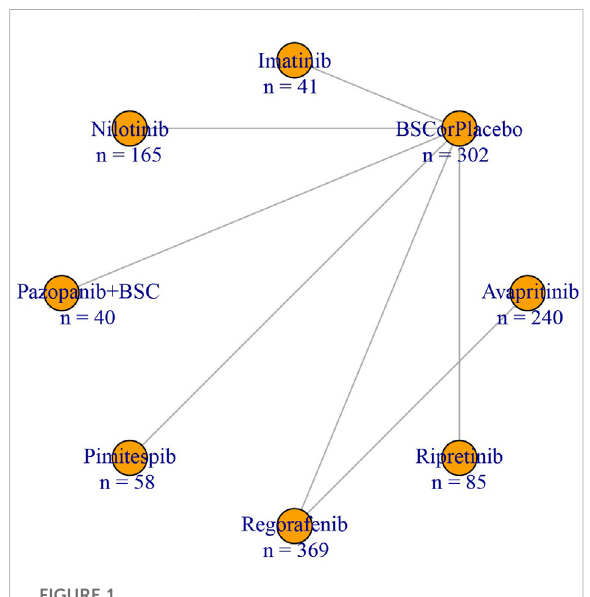
FIGURE 1 Network structure plot of progress-free survival and the disease control rate for regimens included in the network meta-